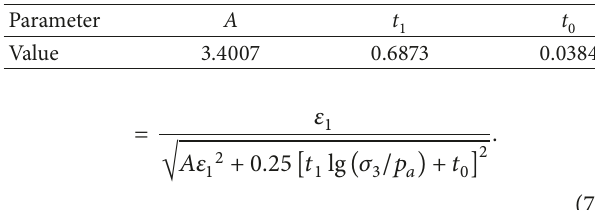
Figure 10: The conventional triaxial test results. Table 6: Measured results for the fitted